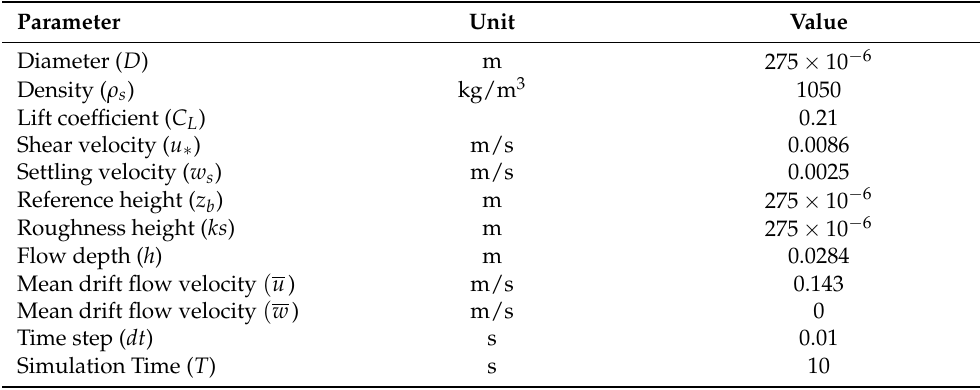
Table 3. Particle, flow conditions and simulation